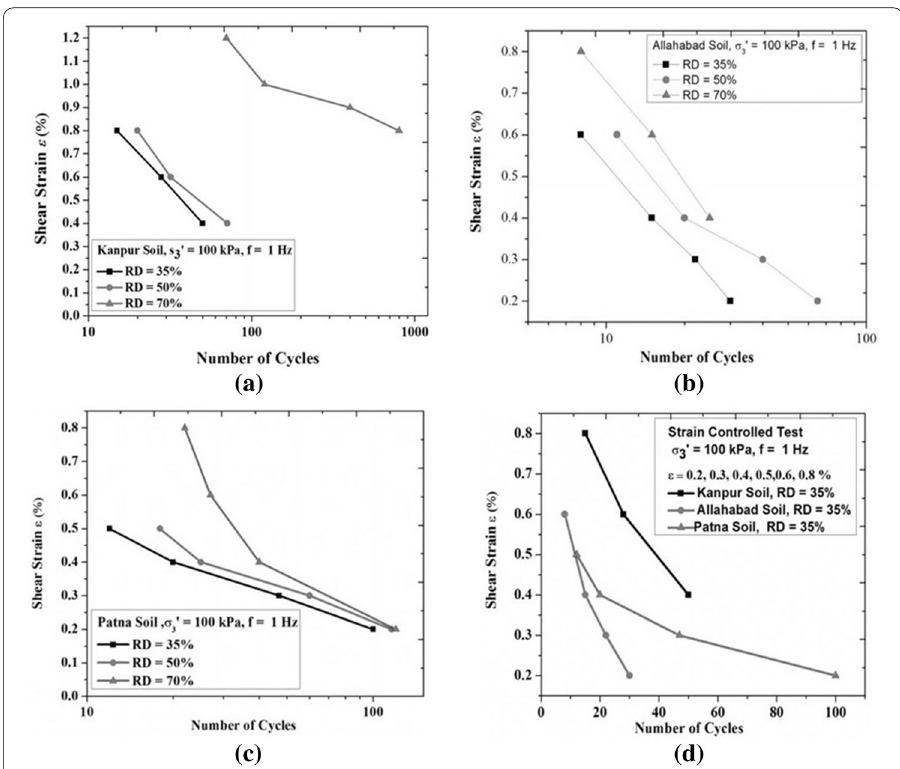
Fig. 7 Relationship between axial shear strain amplitude and number of cycles for initial liquefaction a for Kanpur soil, b for Allahabad soil, c for Patna soil, and d Comparative study of axial shear strain and number of cycles for initial liquefaction for Kanpur soil, Allahabad soil and Patna soil with various strain amplitudes with relative density of 35% and frequency of 1